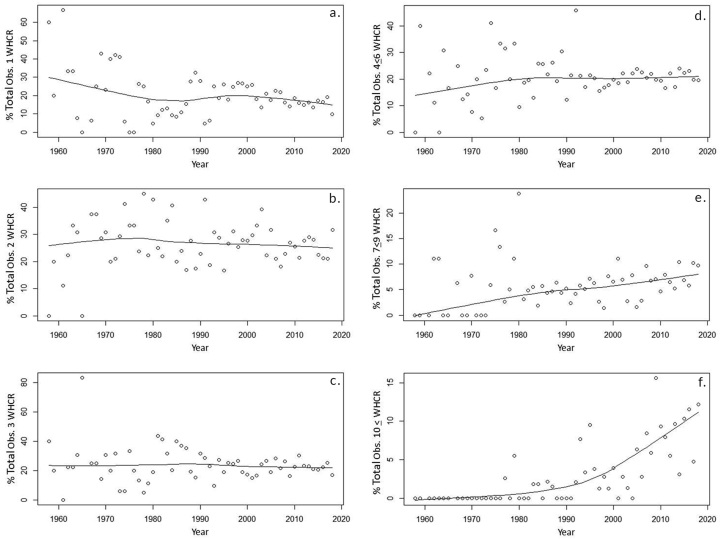
Scatterplots fit with LOESS (locally weighted smoothing) trend lines demonstrating the percentage of total Whooping Crane groups observed of various size classes by observation year from 1958-2018, including groups composed of individual (a), 2 (b), 3 (c), 4–6 (d), 7–9 (e), and ≥10 Whooping Cranes.